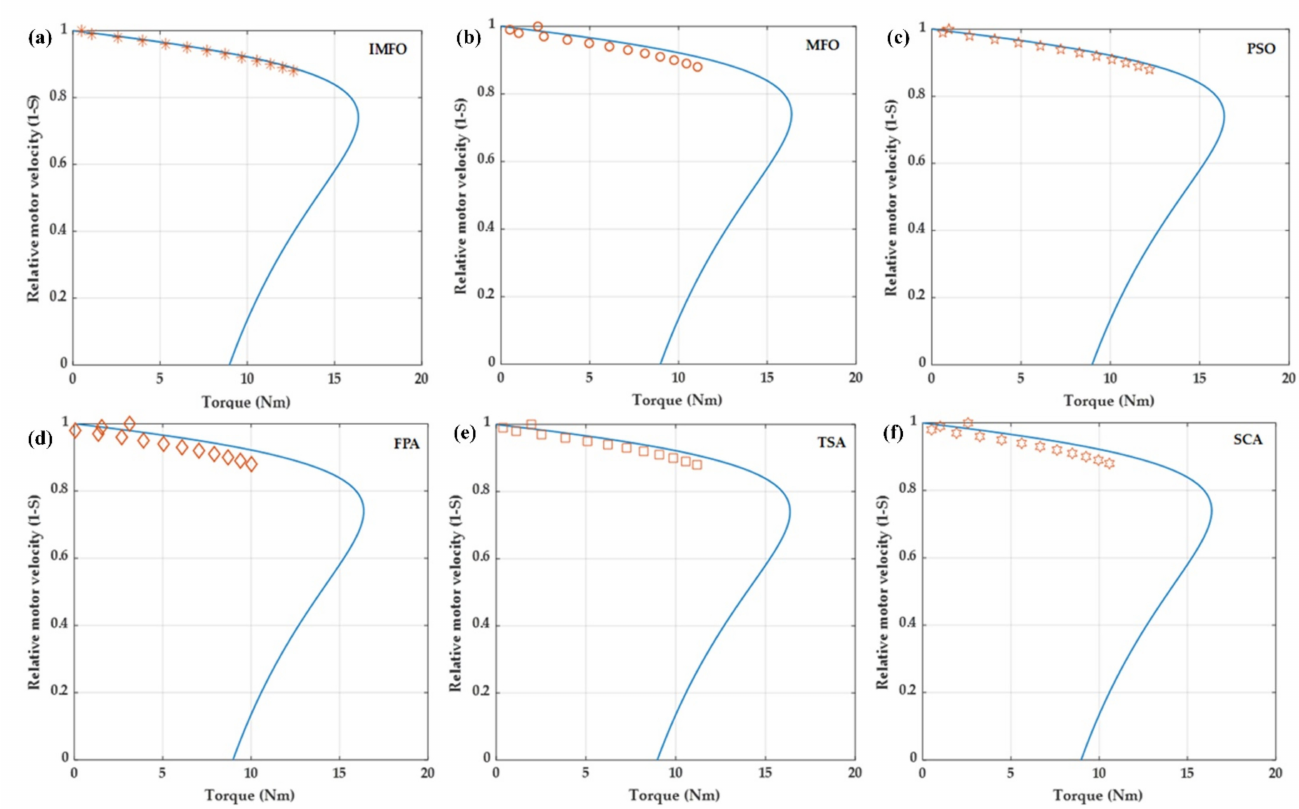
Figure 5. Comparison of experimental and simulated data obtained by ( a ) IMFO, ( b ) MFO, ( c ) PSO, ( d ) FPA, ( e ) TSA, and ( f ) SCA for the equivalent circuit of three phase induction